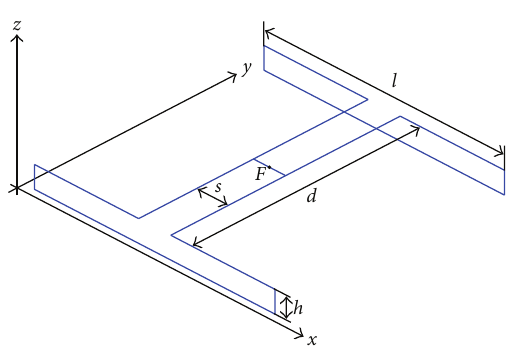
Figure 8: Two-element array of folded dipoles with l = 492 . 9 mm and d = 470